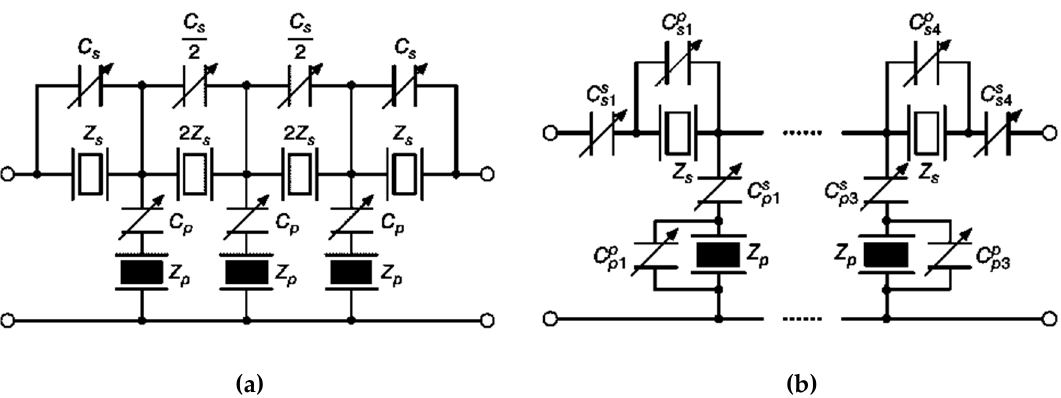
Figure 5. A reconfigurable filter topology using: ( a ) Acoustic wave resonators and variable capacitors; ( b ) SAW/ BAW resonators and varactors [48].